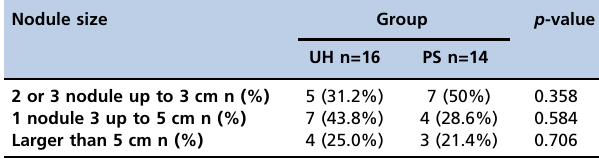
Table 3 - Size and number of nodules of hepatocellular carcinoma diagnosed in patients with liver cirrhosis who were followed-up at the University Hospital or private sector in Vito´ria, ES,